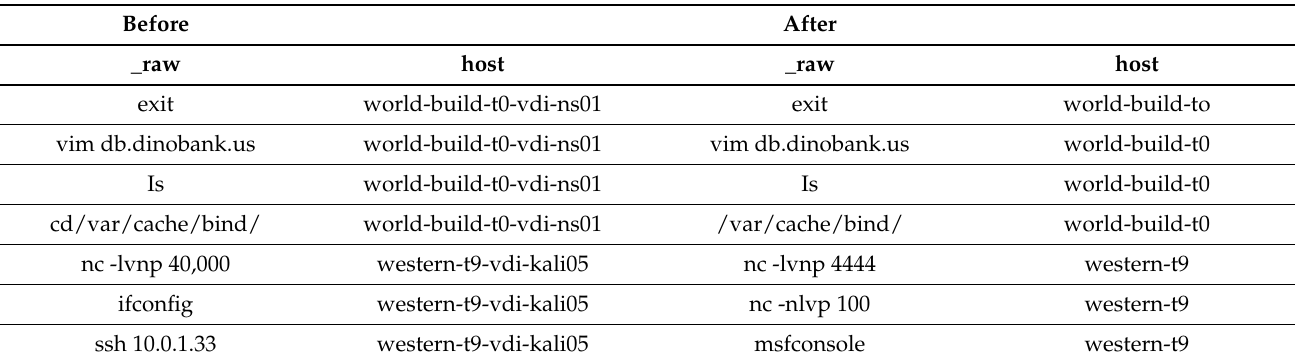
Table 4. Preprocessed team